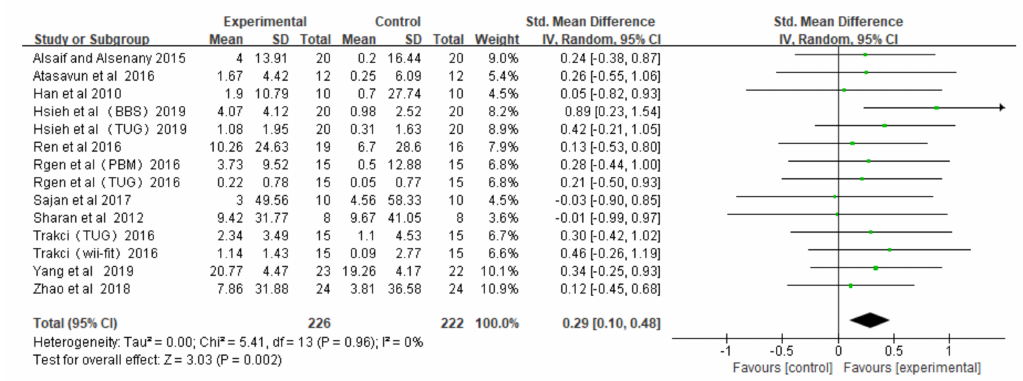
Figure 3. The e ff ect of VR games on the balance of children with cerebral palsy.